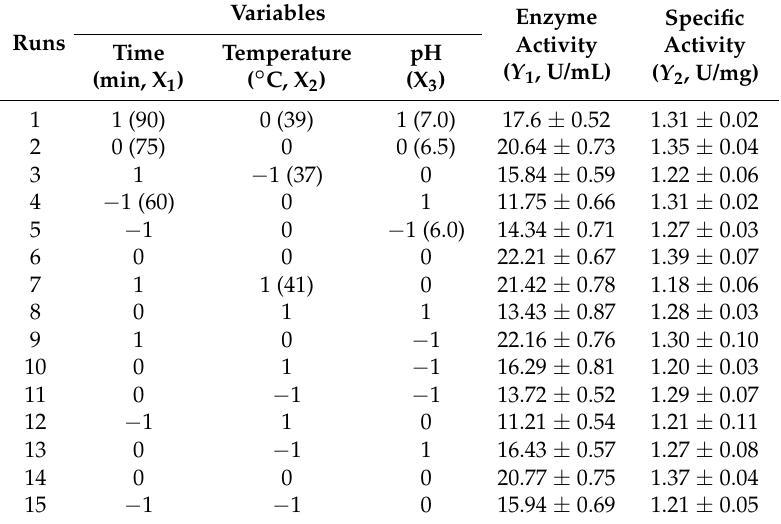
Table 1. Experimental design used in RSM studies by using three independent variables with three central points, showing observed enzyme activity ( Y 1 , U/mL) and specific activity ( Y 2 , U/mg). Time (min, X 1 ), temperature ( ◦ C, X 2 ) and pH (X 3 ) were chosen as the three independent variables.